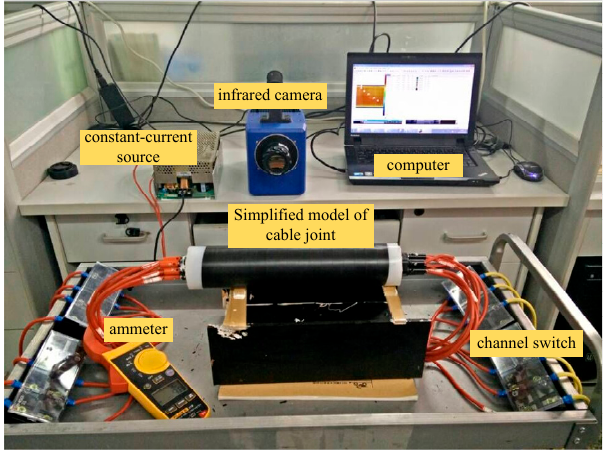
Figure 11. Schematic diagram of the experimental scheme.